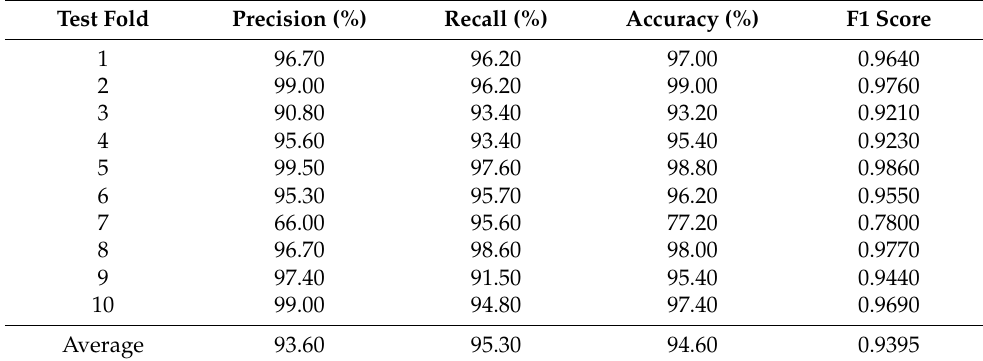
Table 13. Experimental results of K-fold cross-validation ( K f = 10) for Model #1–4 with 32 Kernel convolutional windows and 32 maximum pooling windows in each convolutional-pooling layer.